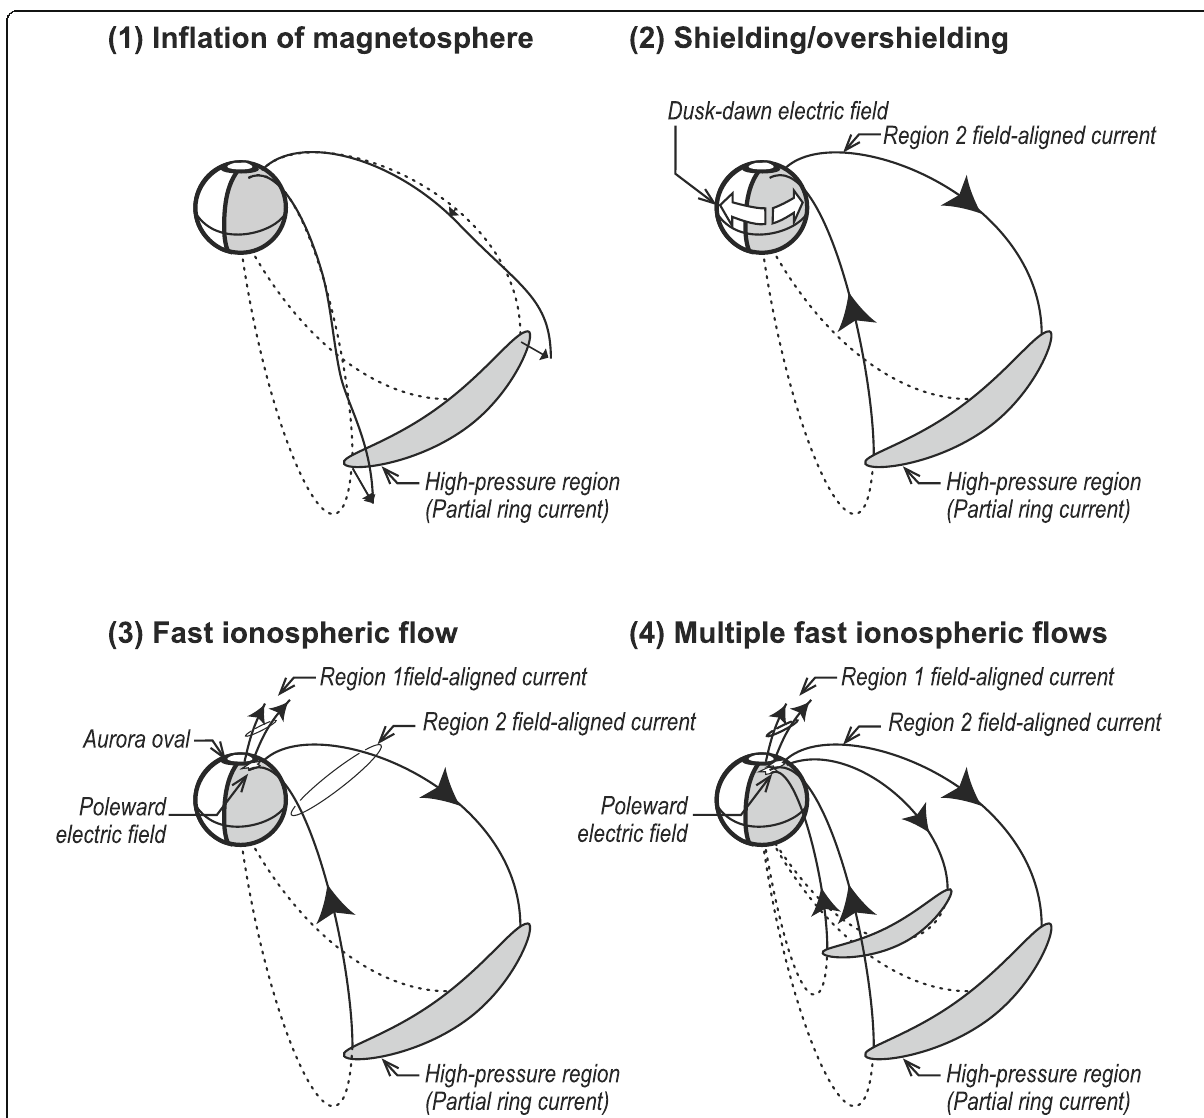
Fig. 14 Active role of the storm-time ring current; 1 inflation of the magnetic field, 2 development of the shielding/overshielding electric field (dusk-dawn electric field), 3 development of fast ionospheric flow (poleward electric field), and 4 development of multiple fast ionospheric flow (poleward electric